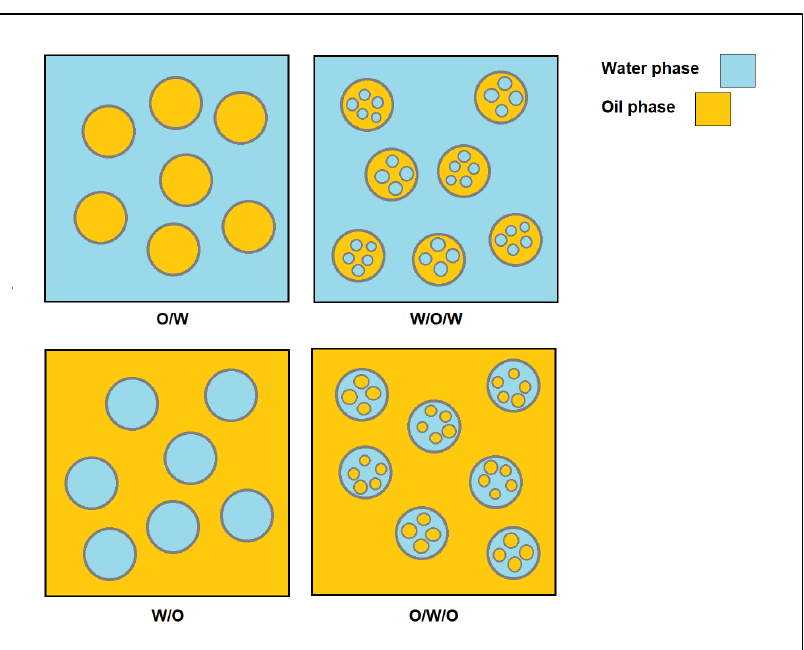
Figure 4. Schematic diagram of the different types of emulsions formed between water and oil.